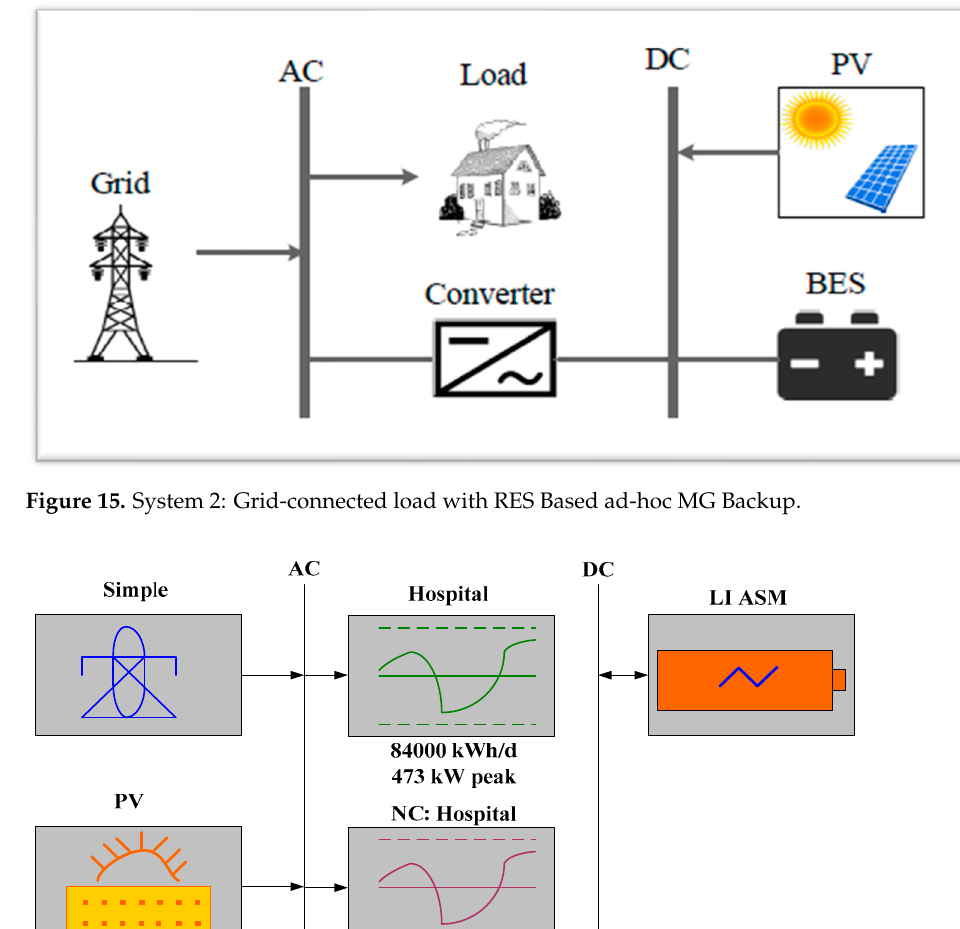
Figure 17. Resilience diagram for System 2.